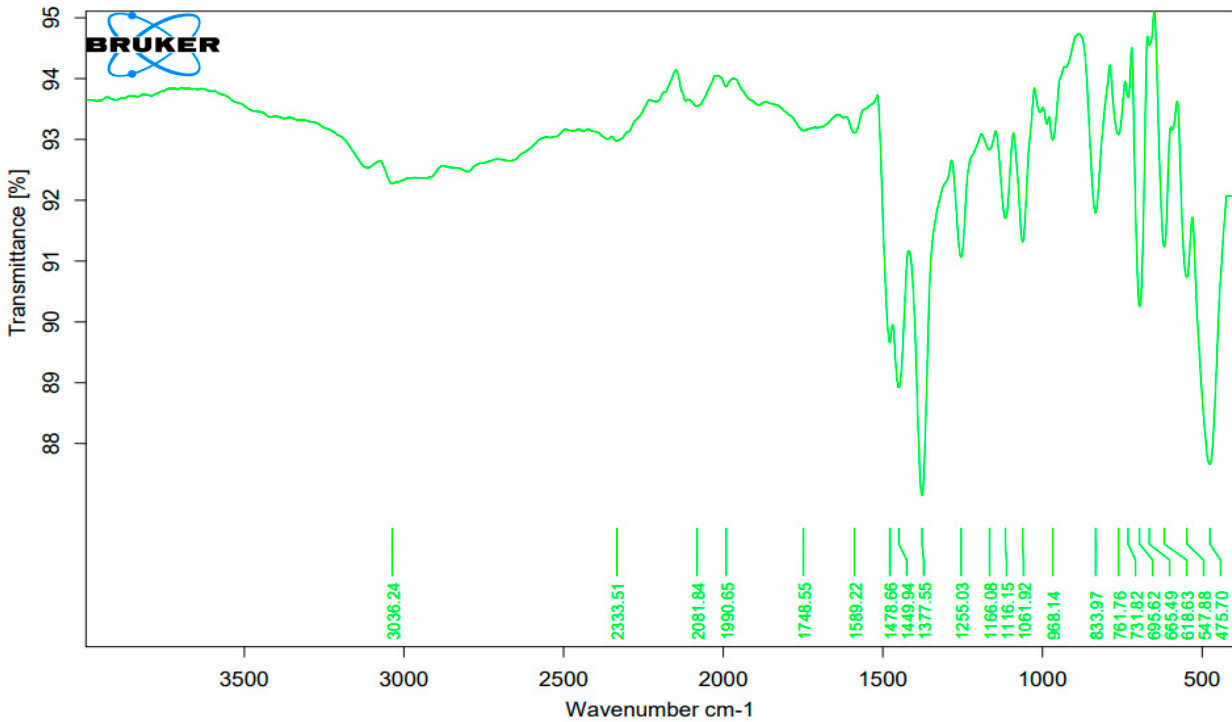
Figure 3. FTIR spectra of antimony(III)-tris ( N -methyl- N -phenyl dithiocarbamate) complex.